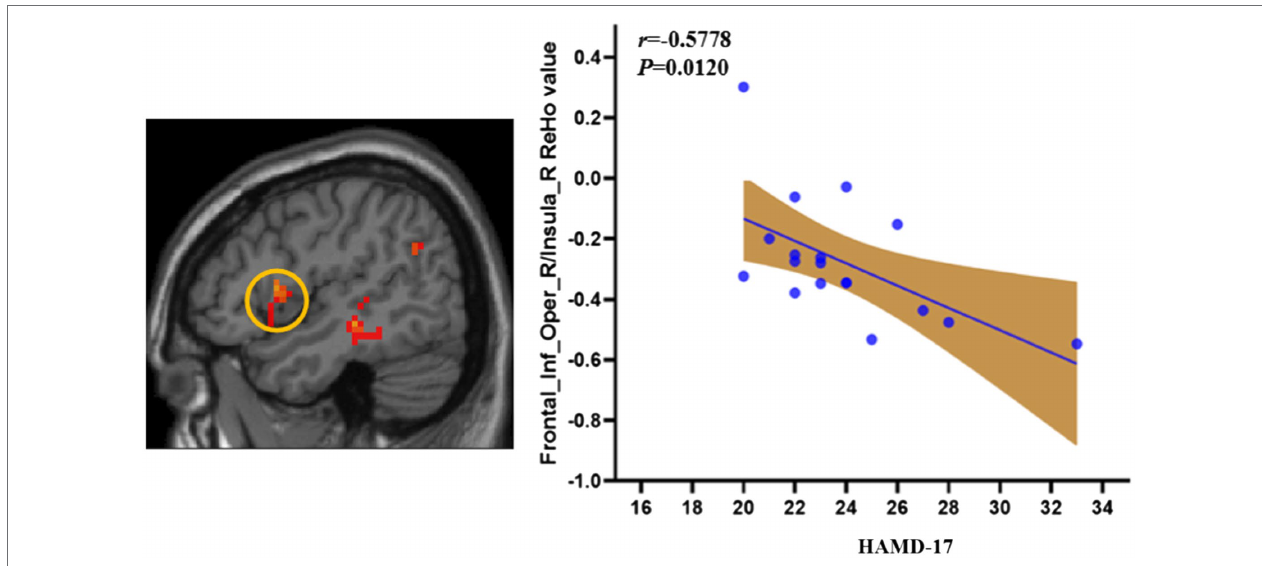
FIGURE 3 | The correlation of the ReHo and HDRS symptom in LORD patients. LORD, late onset recurrent